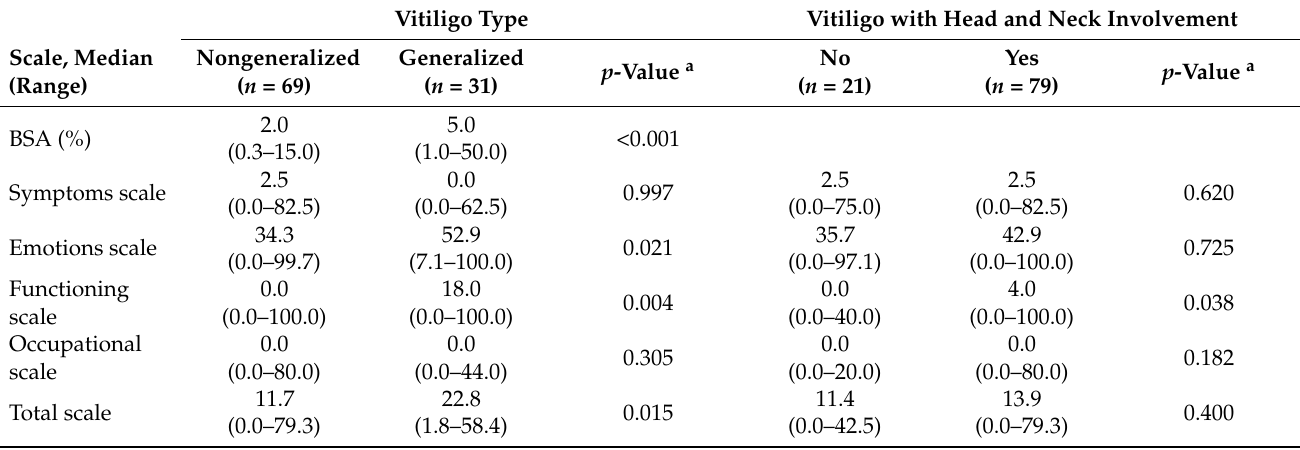
Table 4. Impact of vitiligo involvement on QoL.